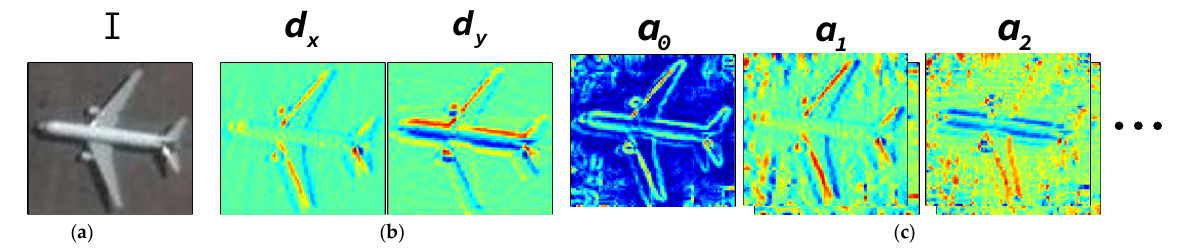
Figure 7. Illustration of the expansion of gradient images to Fourier coefficient images. ( a ) The input image; ( b ) the gradient image; ( c ) the complex Fourier coefficient images.